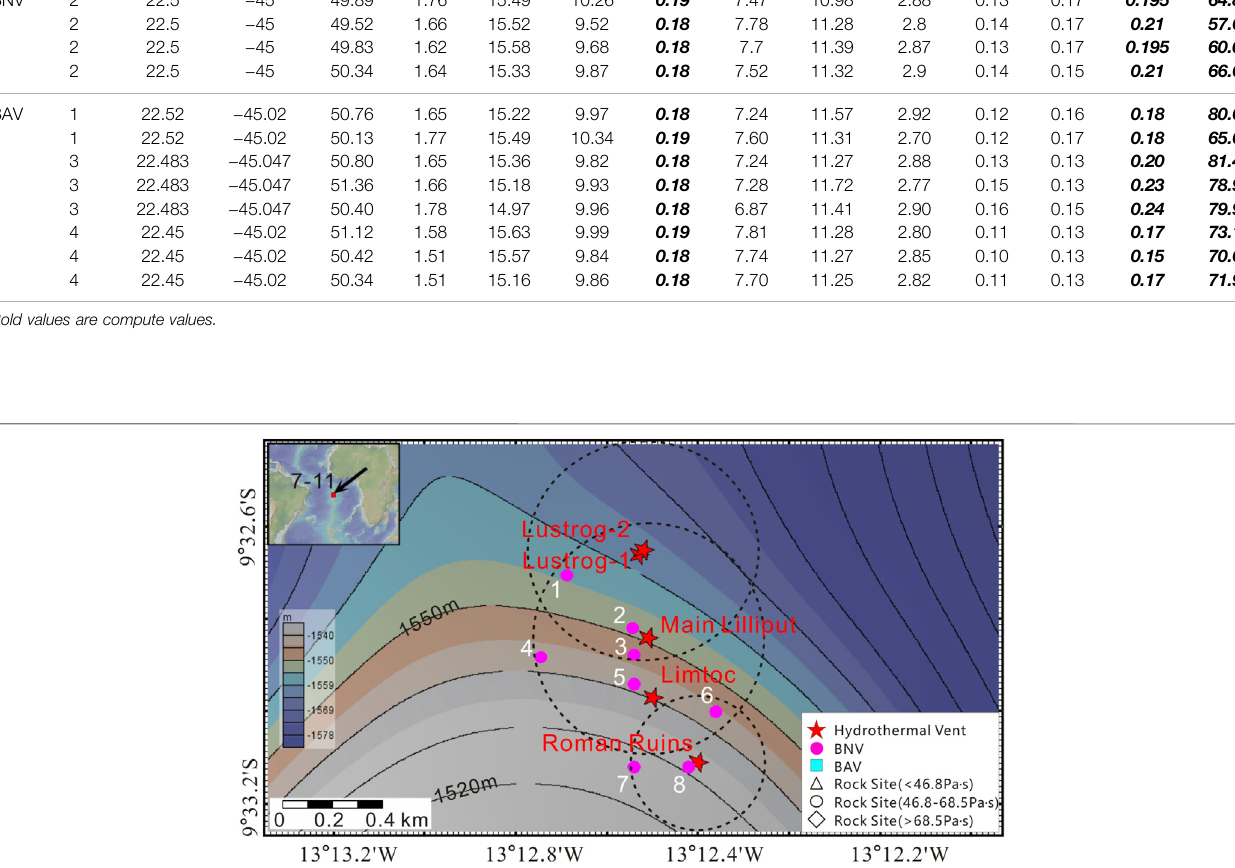
Frontiers in Earth Science |